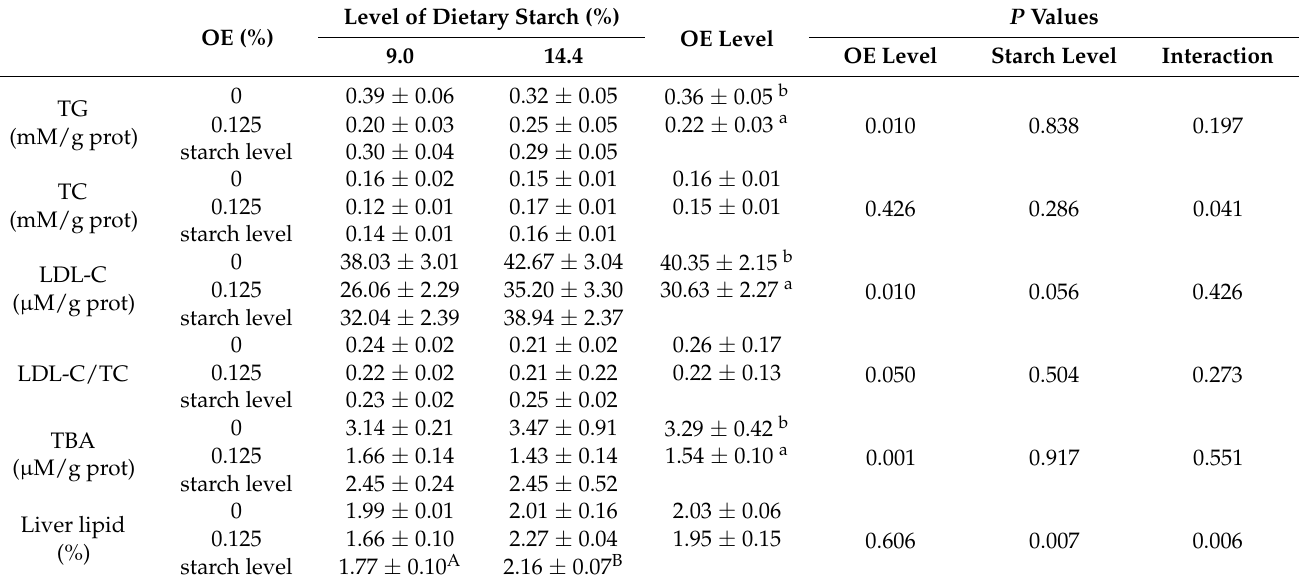
Table 9. Effects of experimental diets on hepatic lipid metabolism parameters in largemouth